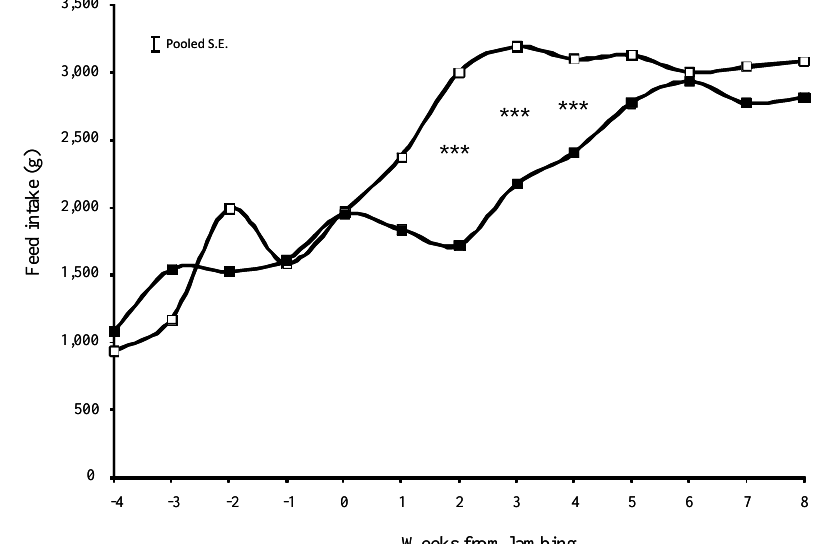
Figure 1. Feed intake in Dorper ewes fed a Control Diet (Control = □ ) or supplemented with Yerba Mate (Yerba Mate = ■ ). Values are expressed as means  SE **